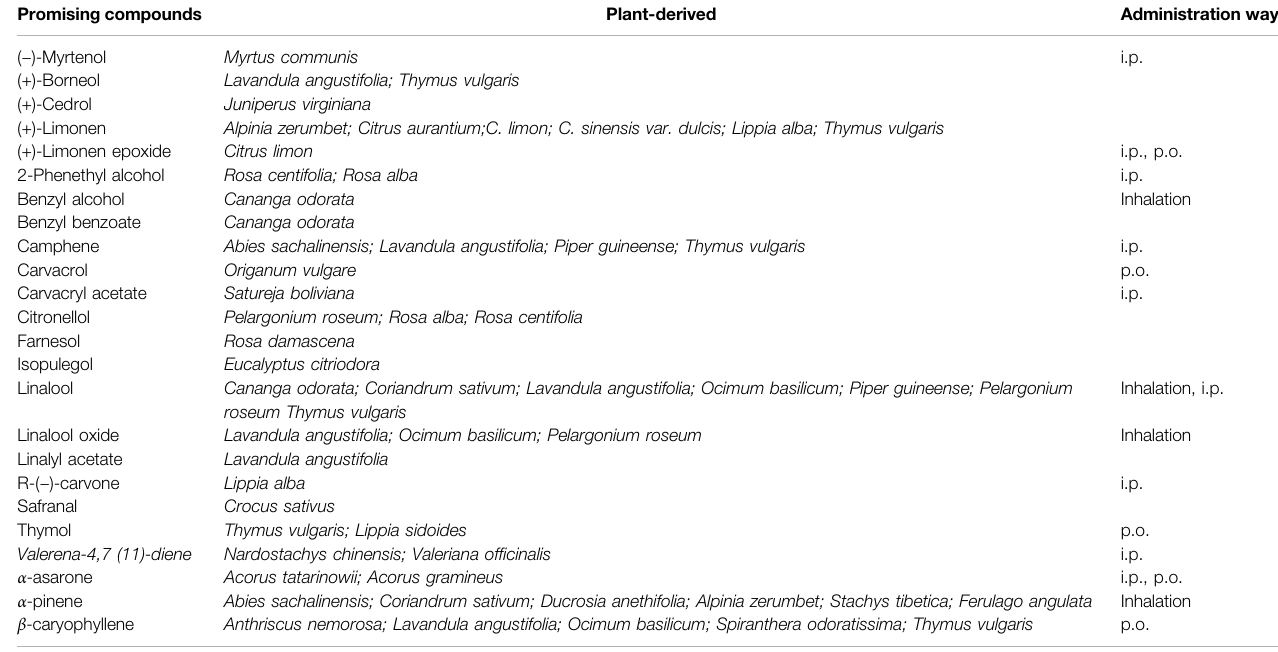
TABLE 4 | Anxiolytic effects of promising compounds from plant-derived essential oils in animal models (de Sousa et al., 2015; Zhang and Yao, 2019). Promising